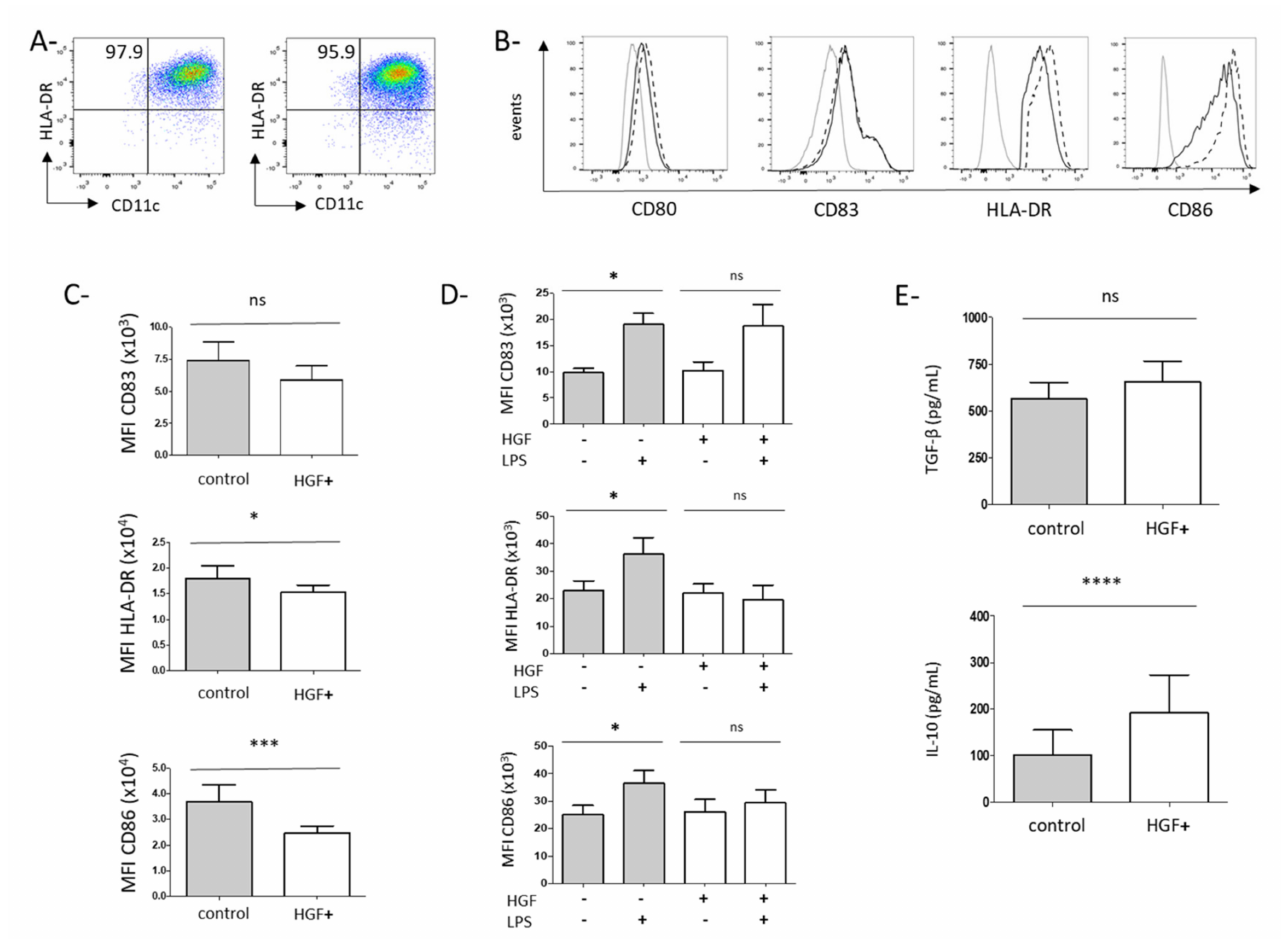
Figure 3. HGF modulates monocyte-derived DC differentiation from GC patients into a regulatory phenotype in vitro. Freshly isolated peripheral monocytes from GC patients were cultured in the presence of GM-CSF and IL-4 with HGF (=HGF condition) or without HGF (=control condition) as described in the material and method section. After 6